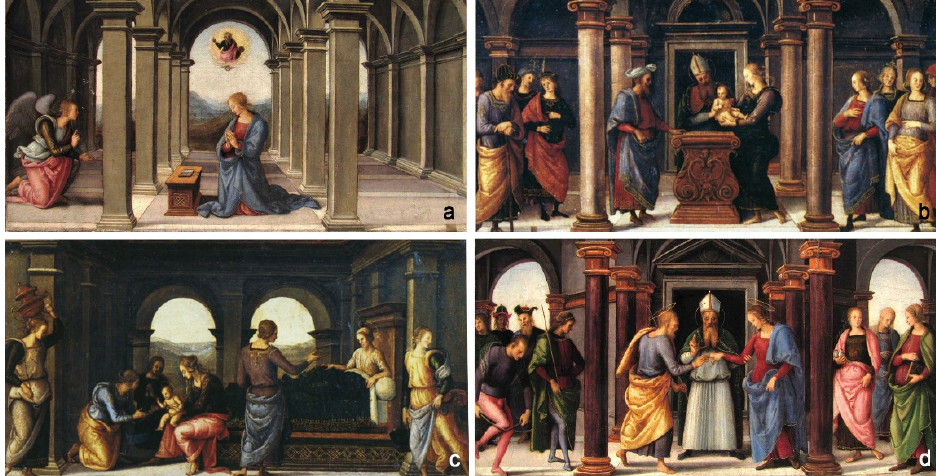
Figure 3. Pietro Vannucci known as Perugino (and Raffaello?), The Fano Altarpiece, 1497, church of S. Maria Nuova, Fano: ( a ) The Annunciation; ( b ) The Presentation; ( c ) The Stories of the Virgin; ( d ) The Marriage.